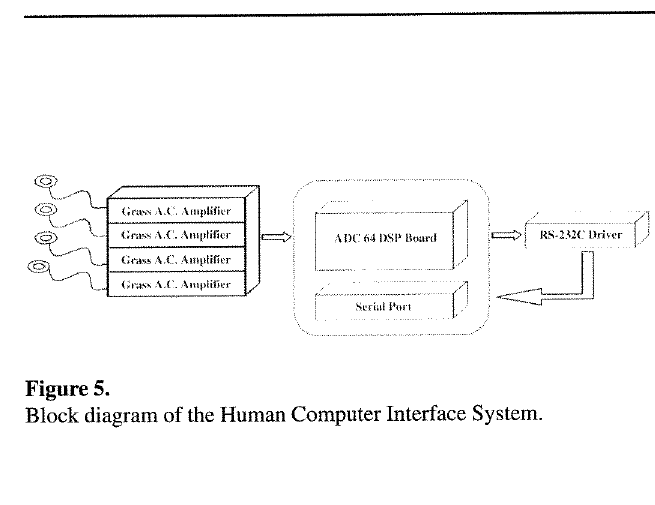
Figure 5. Block diagram of the Human Computer Interface